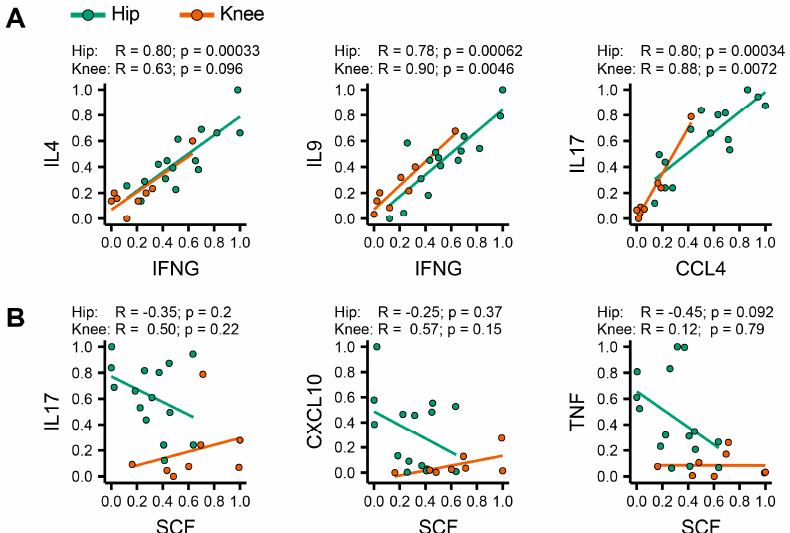
Figure 4. Correlation between soluble mediators. ( A ) We selected pairs of highly correlated cytokines from the cluster shown in Figure 2B and plotted individual relative expression values against each other. IFNG, IL4, IL9, CCL4, IL17, CCL11 (not shown), and CCL3 (not shown) are each highly predictive of each other’s expression. ( B ) Context sensitivity of coordinated cytokine expression programs. Expression of stem cell factor (SCF) is not correlated with TNF and slightly positively correlated with IL-17 and CXCL10 in knee OA, but strongly negatively correlated with all three cytokines in hip OA. Spearman correlation values and p-values are shown separately for hip and knee OA.